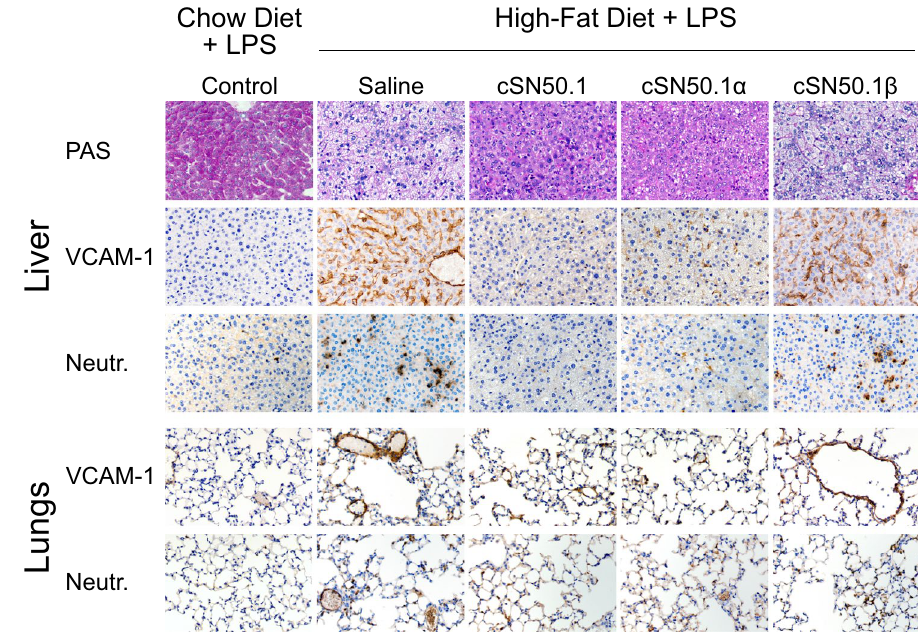
Figure 7. Multi-organ injury in the LPS-induced microbial inflammation in hyperlipidemic mice is prevented only by treatment with NTMs targeting nuclear import pathways of SRTFs and ChREBPs mediated by Imp α5 pathway whereas targeting Imp β1-mediated pathway with cSN50.1β peptide is ineffective in the Short- Term treatment protocol. LPS-induced glycogenolysis (PAS) in the liver, microvascular endothelial injury (VCAM-1; in the liver, and lungs) and inflammatory cells infiltration (neutrophils; in the liver, and lungs) are attenuated by treatment targeting nuclear import pathway mediated by Imp α5 with monoselective NTM cSN50.1α and biselective NTM cSN50.1. Targeting Imp β1-mediated pathway with cSN50.1β peptide is ineffective. Representative images (×40 magnification) of liver and lungs sections in LPS-challenged 15-week- old ldlr −/− female mice fed chow diet (control) or mice fed HFD and treated with 15 doses of saline or indicated NTMs given 30 min before LPS challenge and three days thereafter. Data presented in this figure represents 2 independent experiments completed with 5 mice per condition group. See “Methods” for